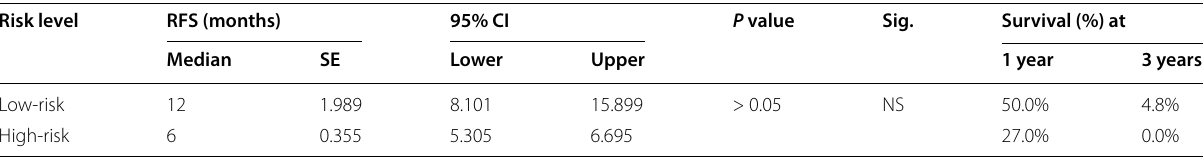
Table 4 Recurrence-free survival (RFS) in low- and high-risk patients Risk level RFS (months) RFS Recurrence-free survival, NS Nonsignificant, CI Confidence interval